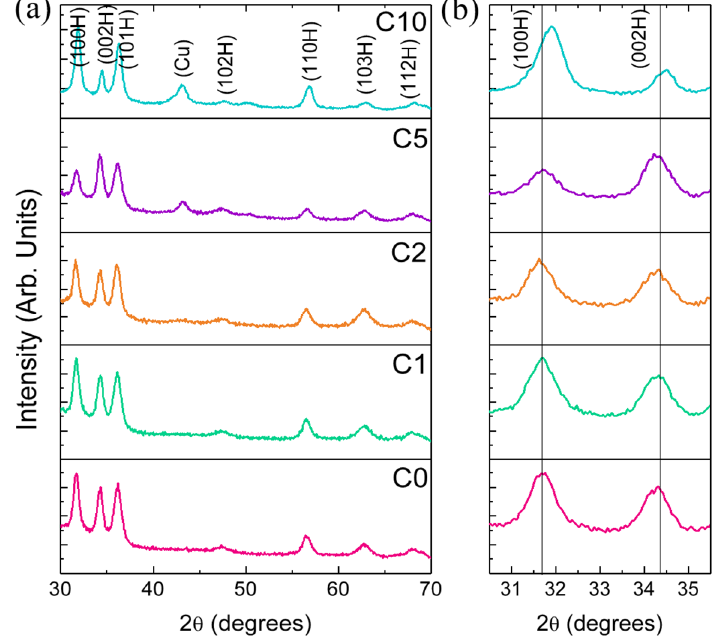
Figure 1. ( a ) XRD spectra of pristine ZnO (C0) and co-sputtered Cu-ZnO thin films (C x ). ( b ) Enlarged XRD peaks for (100H) and (002H). The reference peak positions, (100H) at 31.6 ◦ and (002H) at 34.3 ◦ , are indicated as vertical lines.